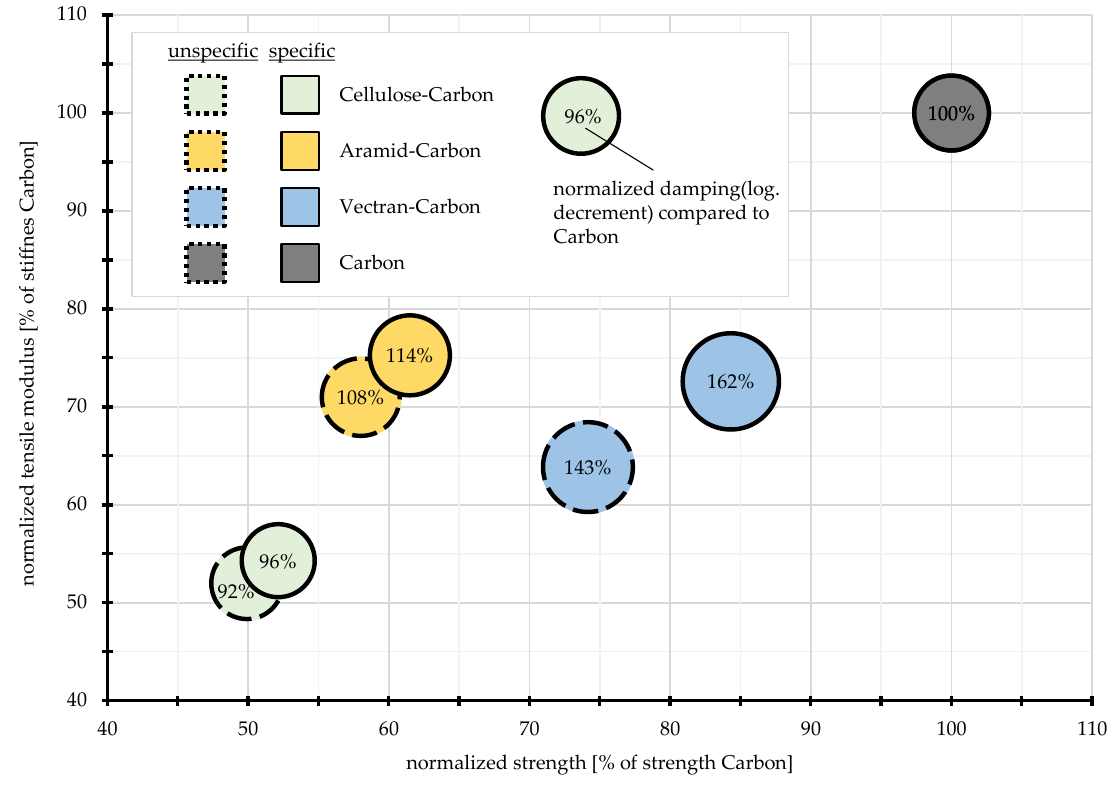
Figure 10. Effect of density on stiffness, strength and damping in fiber direction.